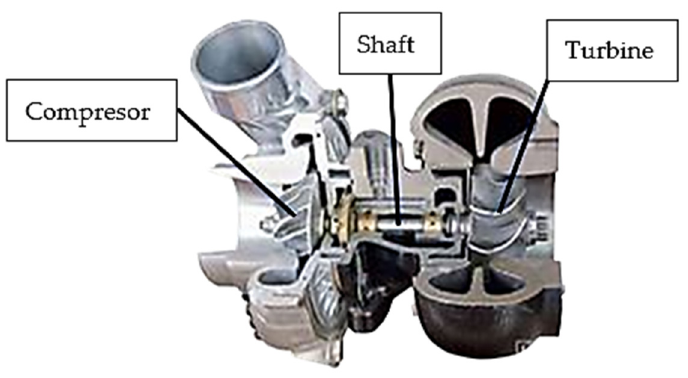
Figure 1. Components of a turbocharger.